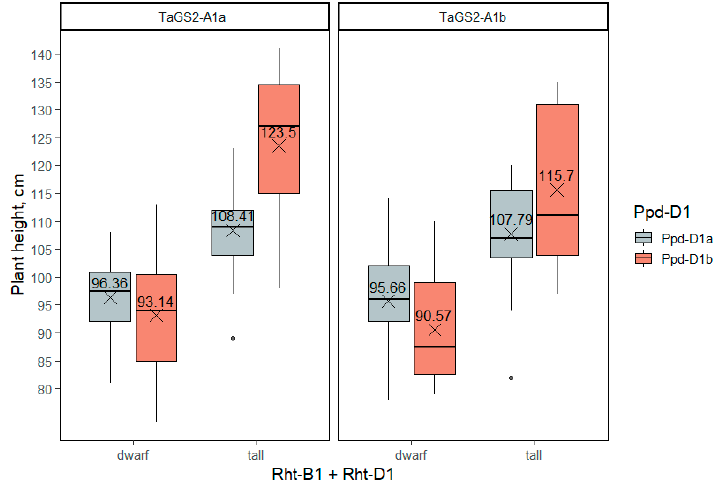
Figure 4. The plant height of wheat accessions differing in genotypes of the three groups of genes— Rht-B1 + Rht-D1 , Ppd-D1 , TaGS2-A1 . The dots indicate outliers.